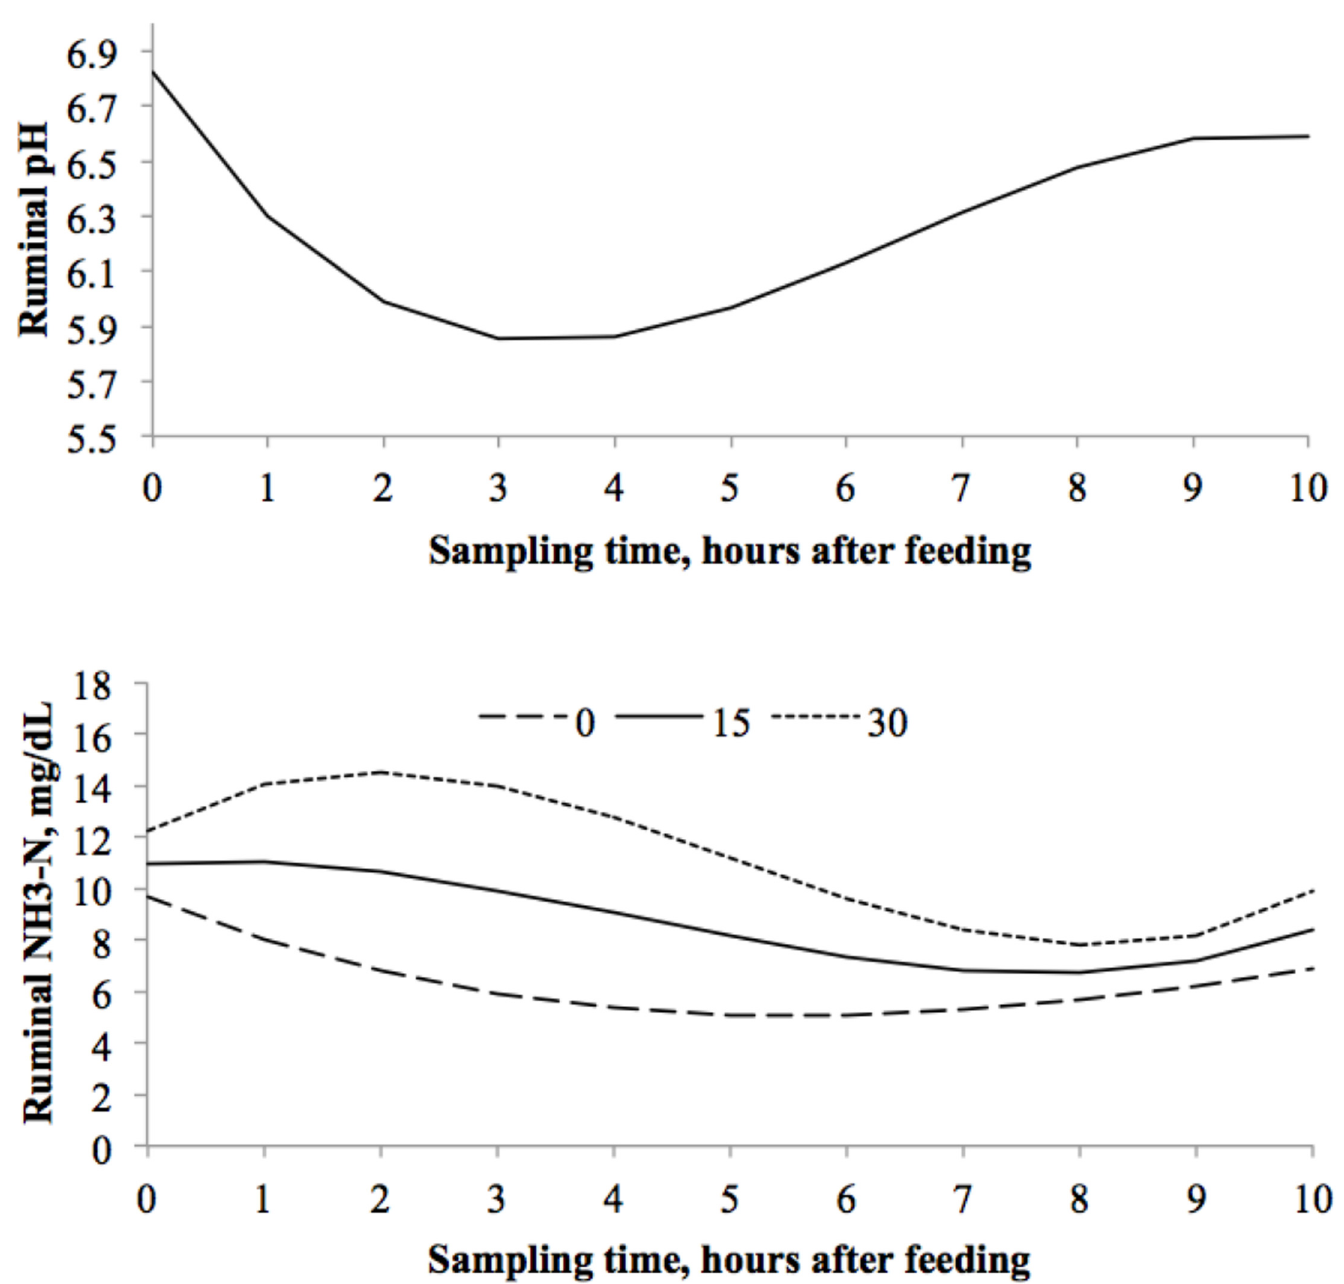
Fig 1. Effect of glycerin inclusion on ruminal pH and NH 3 -N over time in dual-flow continuous culture system. pH = 6.825 ± 0.1727 - (TIME x 0.6487 ± 0.07149) + (TIME 2 x 0.1281 ± 0.01751) — (TIME 3 x 0.00656 ± 0.001143); R 2 = 0.999, MSE = 0.139. NH 3 -N = 9.6399 ± 1.4148 + (glycerin x 0.08728 ± 0.05779) + (glycerin x TIME x 0.146 ± 0.06041) — (TIME x 1.8245 ± 1.1698) — (glycerin x TIME 2 x 0.03459 ± 0.0148) + (TIME 2 x 0.2095 ± 0.2866)